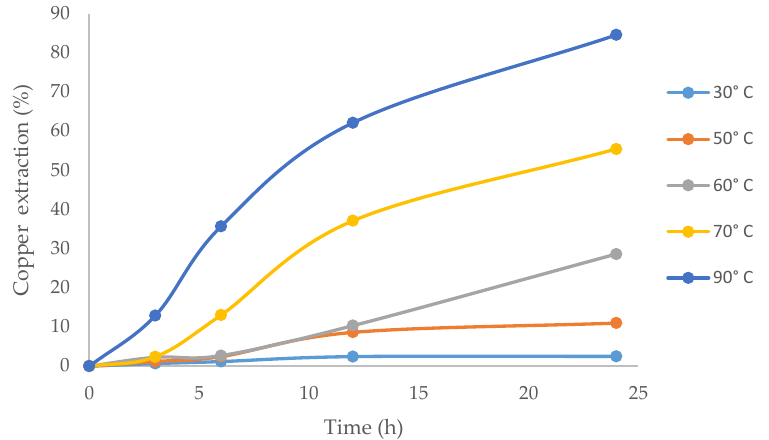
Figure 6. The effect of temperature on copper extraction from chalcopyrite using ionic liquid at 20% ( v / v ) and 100 g / L of Br − .